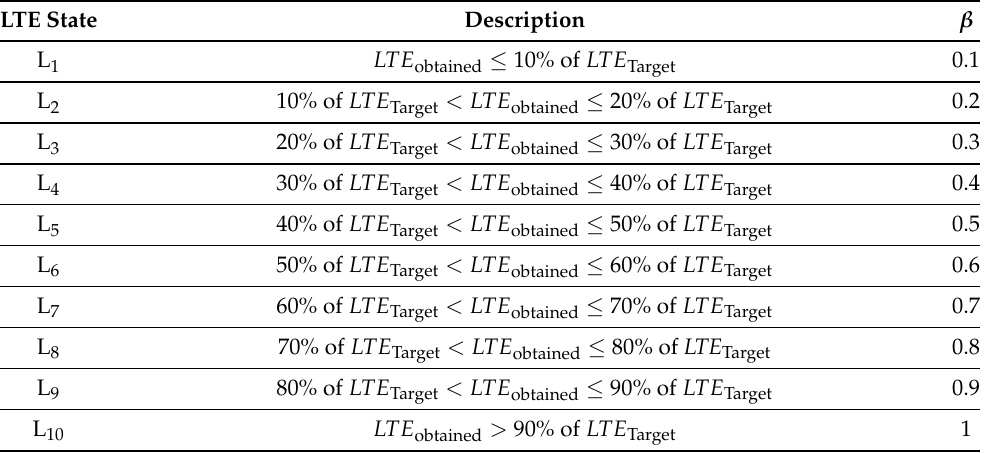
Table 2. LTE states and β